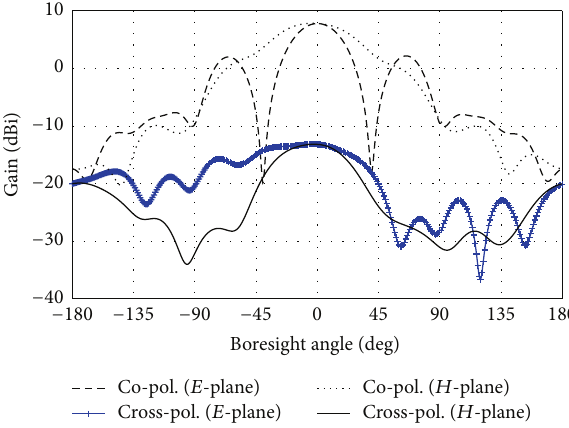
Figure 5: Radiation patterns of the designed double-ridged horn antenna in two principal planes at 2.4